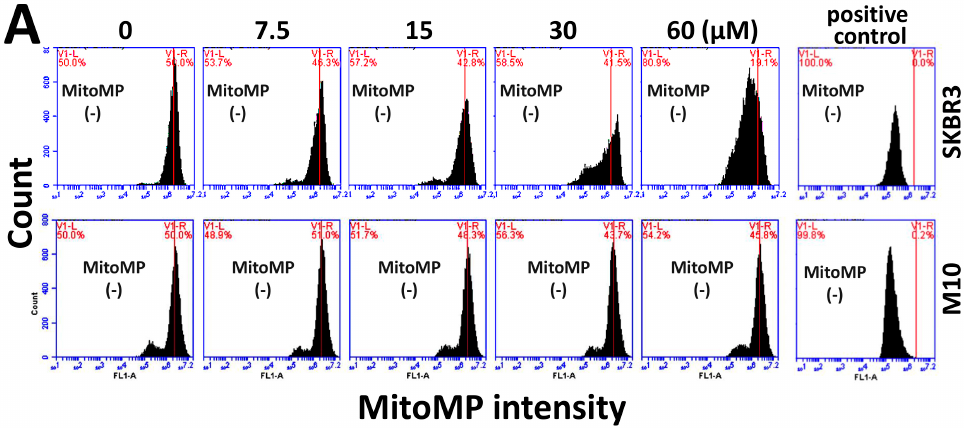
Figure 6. Change of MitoMP in sinularin-treated breast cancer (SKBR3) cells. ( A ) Representative dose response of MitoMP profiles for sinularin-treated SKBR3 cells using flow cytometry. Cells were treated with 0 (DMSO only), 7.5, 15, 30, and 60 µ M of sinularin for 24 h. The left side labeled with MitoMP ( − ) indicates the percentage of the MitoMP-negative region in each panel. Positive control treatment is 50 µ M carbonyl cyanide m-chlorophenyl hydrazone (CCCP) with 20 min incubation. The authors would like to apologize for any inconvenience caused to the readers by these changes which do not affect the scientific results. The manuscript will be updated and the original will remain on the article webpage, with a reference to this